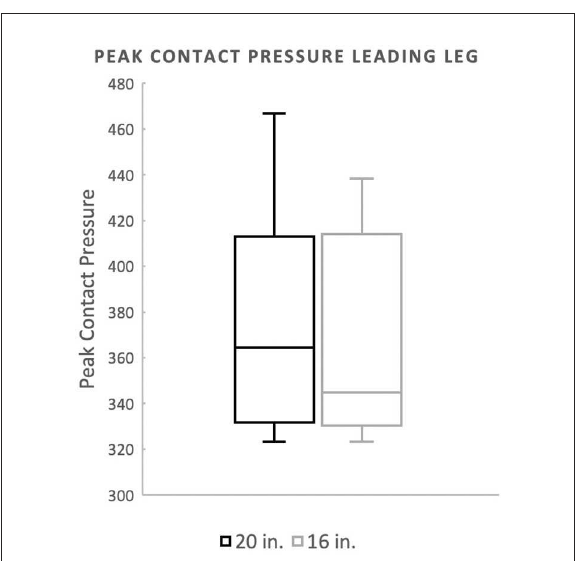
FIGURE7 Mean peak contact pressure of the leading forelimb. There was no significant difference between the standard (20 ′′ ) or preferred (16 ′′ ) height for the leading